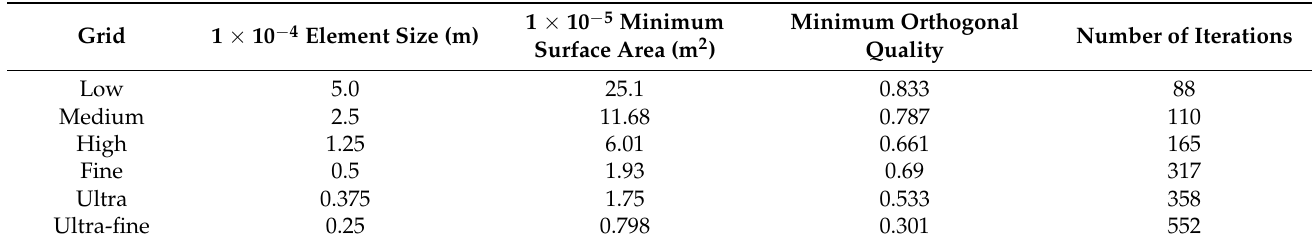
Table 1. The details of the studied mesh distributions.